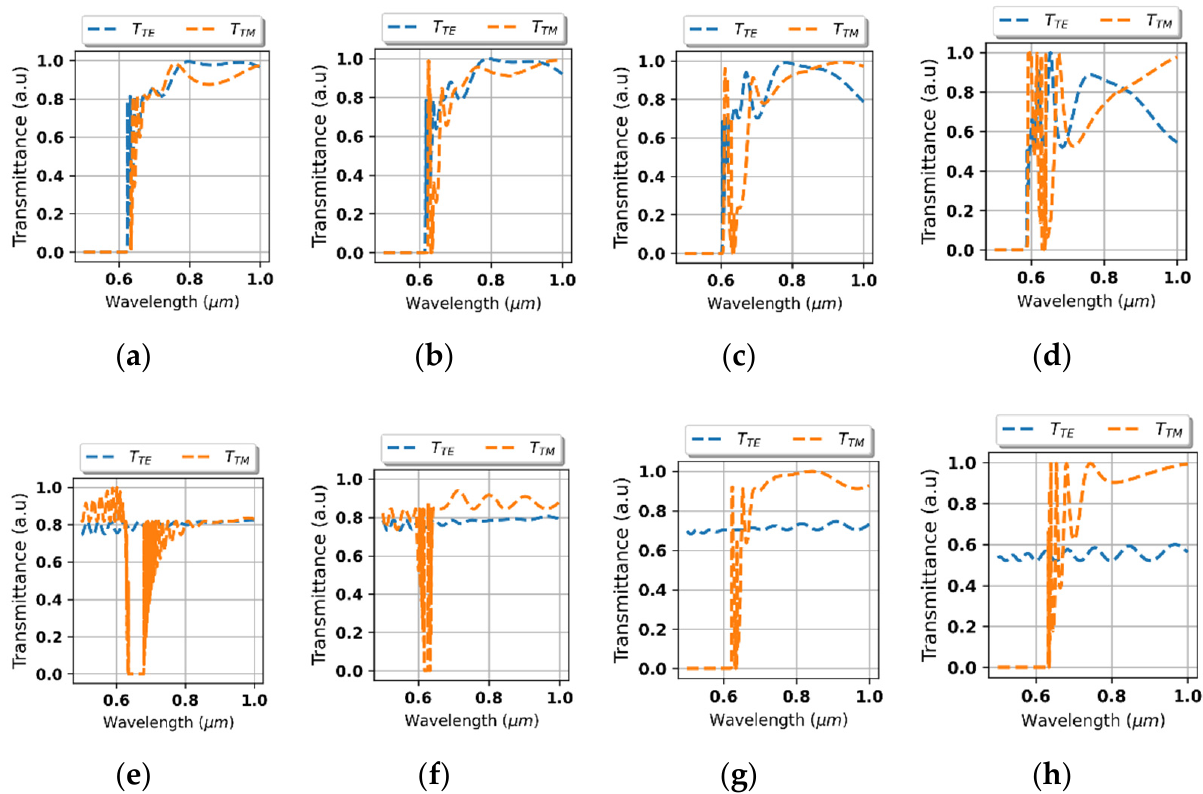
Figure 7. Spectral characteristics of transmittance for waves impinging from the air side ( a – d ) and substrate side ( e – h ) at various angles of incidence ( a ) 5°, ( b ) 25°, ( c ) 45°, ( d ) 65°, ( e ) 185°, ( f ) 205°, ( g ) 225°, and ( h ) 245°.